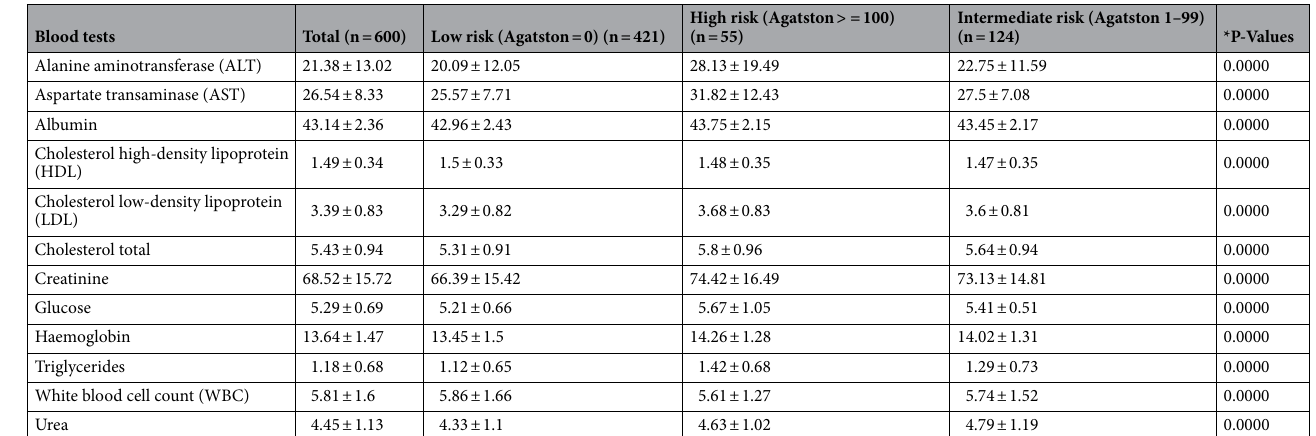
Table 4. Blood test variables by risk